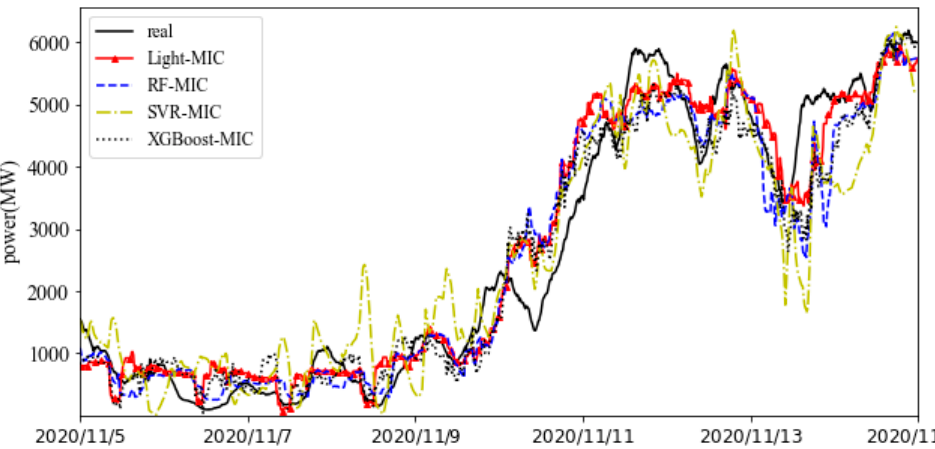
Figure 5. Comparison of output curves of various models in the test phase.